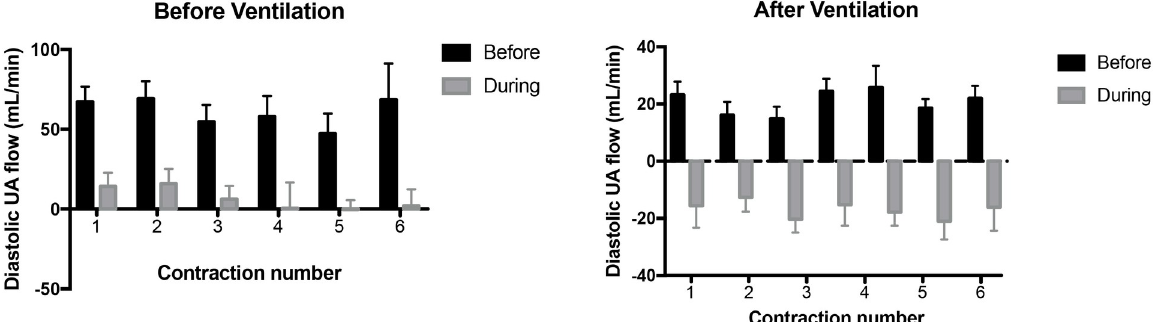
Fig 4. Diastolic blood flow in the umbilical artery (UA) measured immediately before (black bar) and during (grey bar) consecutive uterine contractions and before (BV) and after (AV) ventilation onset. Flows that have a value below zero indicate retrograde flow in the UA. Blood flows measured during each contraction were significantly lower than flows measured immediately prior to the contraction (p < 0.0001).